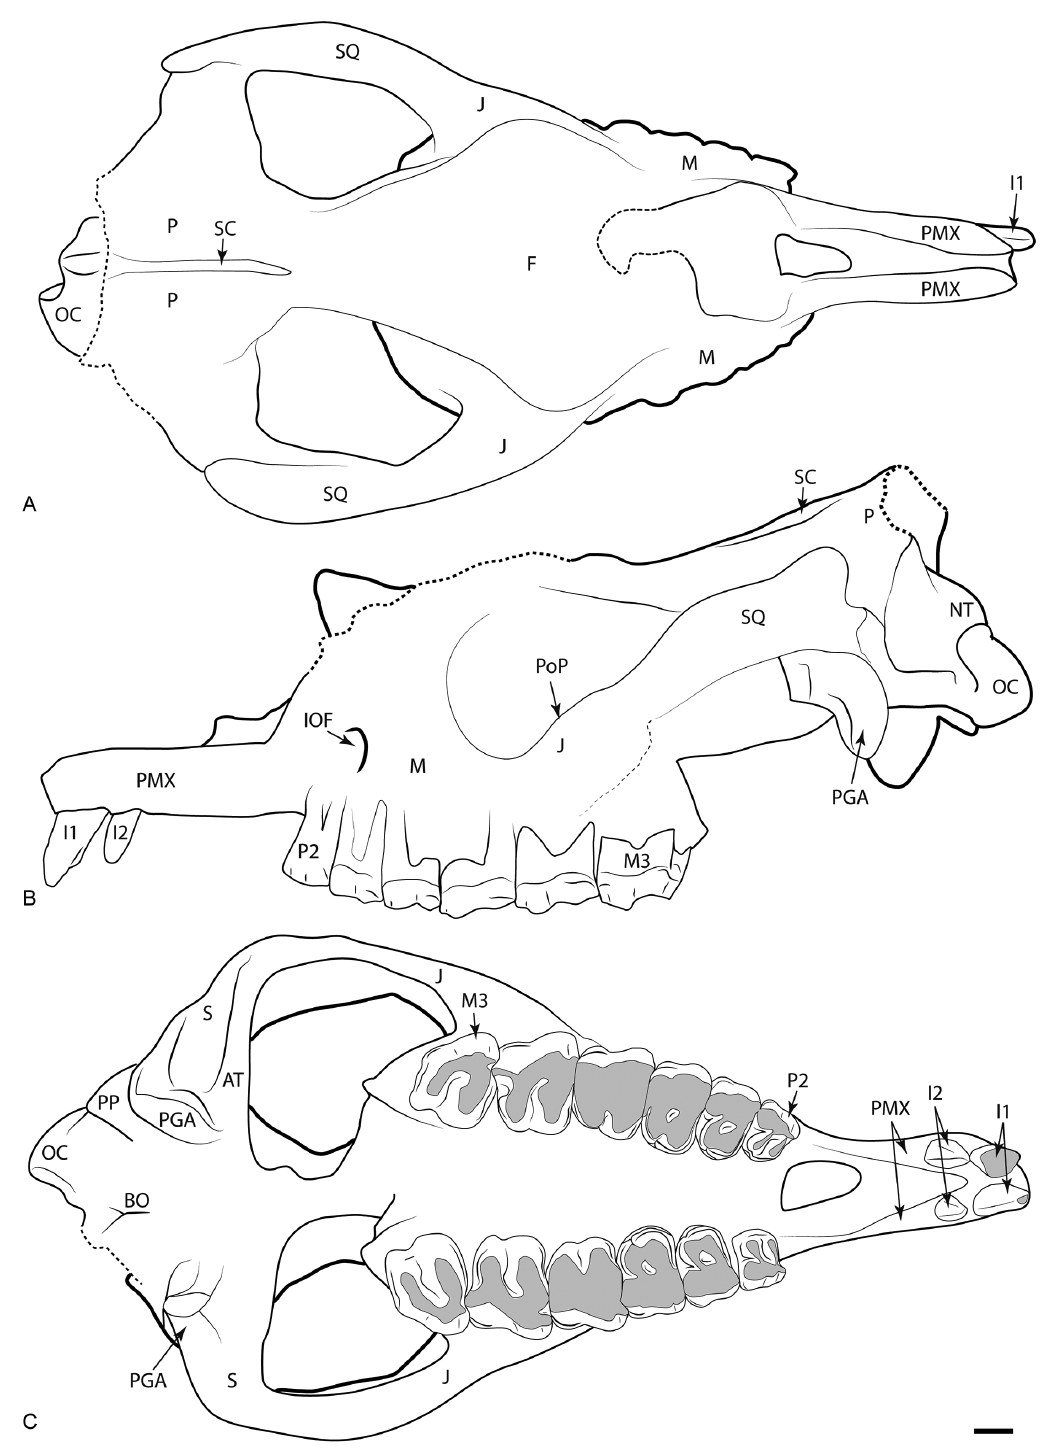
Fig. 23. Ronzotherium heissigi sp. nov. from Vendèze (late early Oligocene, France). Drawing of the skull MNHN.F.LIM181. A . Dorsal view. B . Left lateral view. C . Ventral view. Abbreviations: AT = articular tubercle; BO = basioccipital; F = frontal; IOF = infraorbital foramen; J = jugal; M = maxilla; NT = nuchal tubercle; OC = occipital condyle; P = parietal; PGA = postglenoid apophysis; PMX = premaxilla; PoP = postorbital process; PP = paraoccipital process; SC = sagittal crest; SQ = squamosal. Scale bar: 2